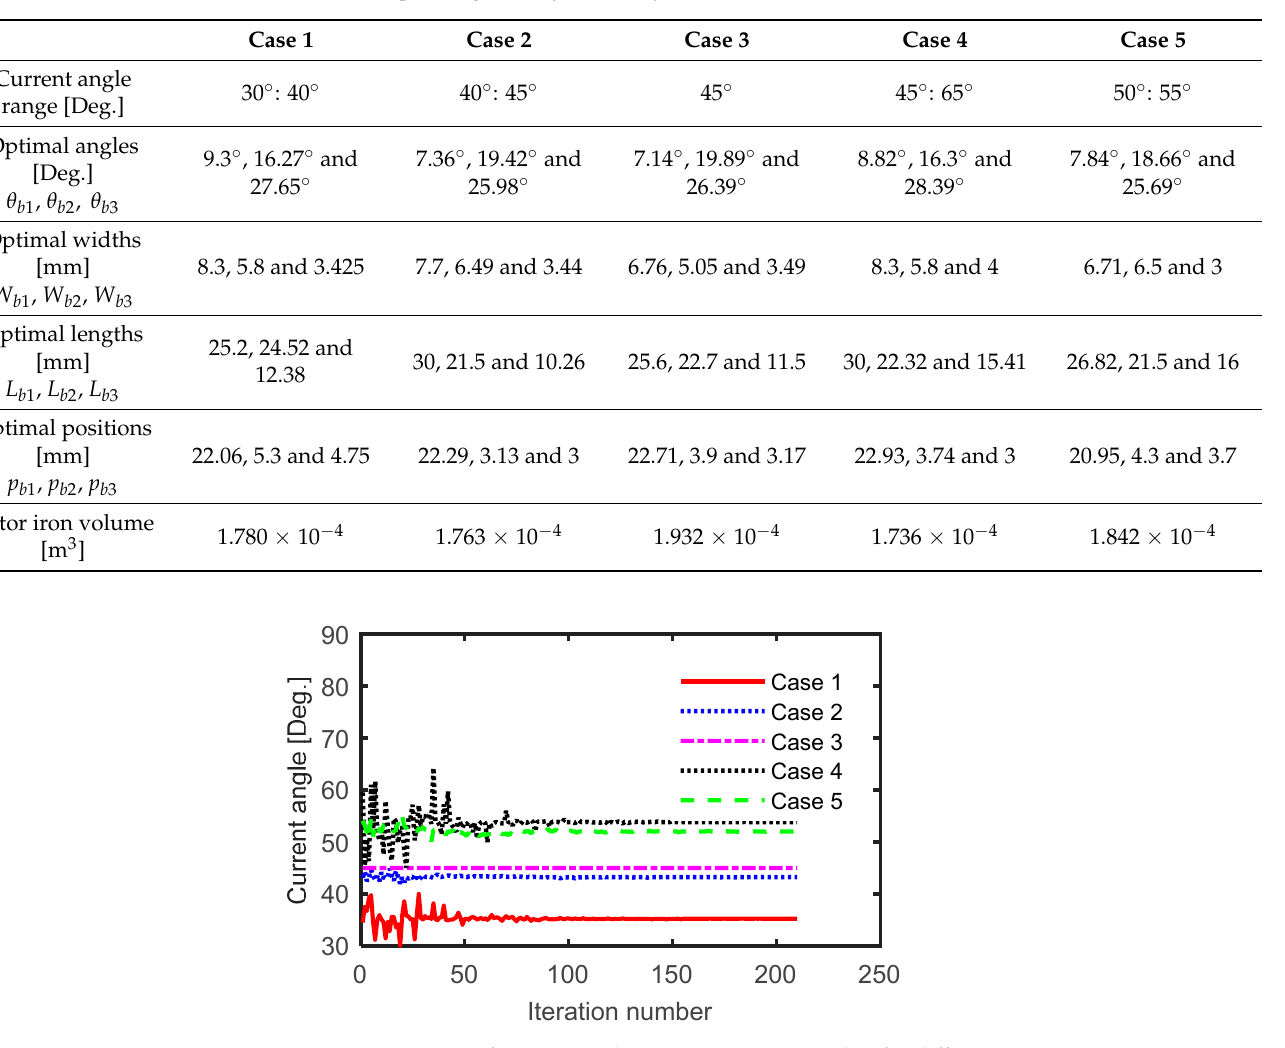
Table 4. Final optimal geometry for the SynRM for different case studies.